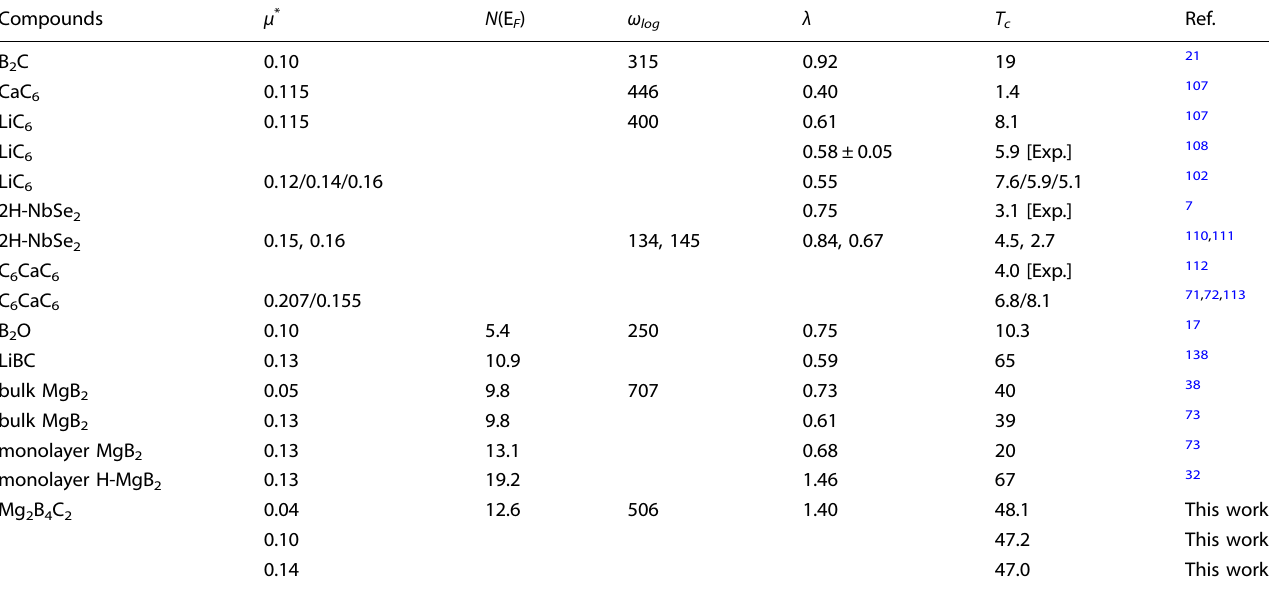
Table 2. Listing of superconducting parameters required for the prediction of T c using the McMillian-Allen-Dynes formula for some reported 2D phonon-mediated superconductors (data for bulk MgB 2 are included for comparison). This table includes data of effective Coulomb screening parameter μ * , electronic DOS at the Fermi level N (E F ) (in states/spin/Ry/cell), logarithmic averaged phonon frequency ω log (in K), total electron- phonon coupling constant λ , and estimated T c (in K). Experimental T c values are noted in the table (see the Supplementary Table 1 for more details).